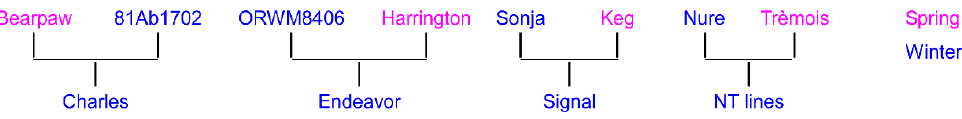
Figure 4. Crosses giving rise to lines exhibiting poor survival in Ohio the 2013–2014 test winter.